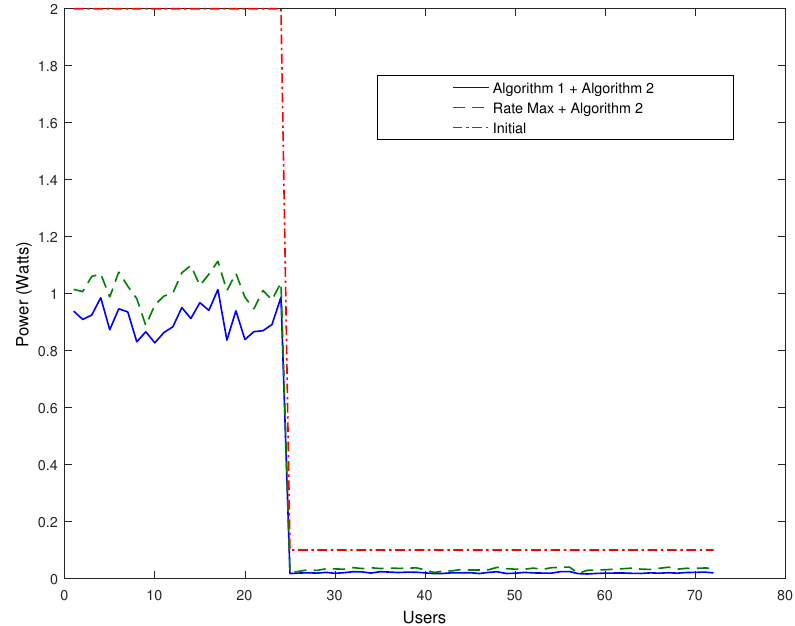
Figure 10. Comparison of the transmission power for the combined